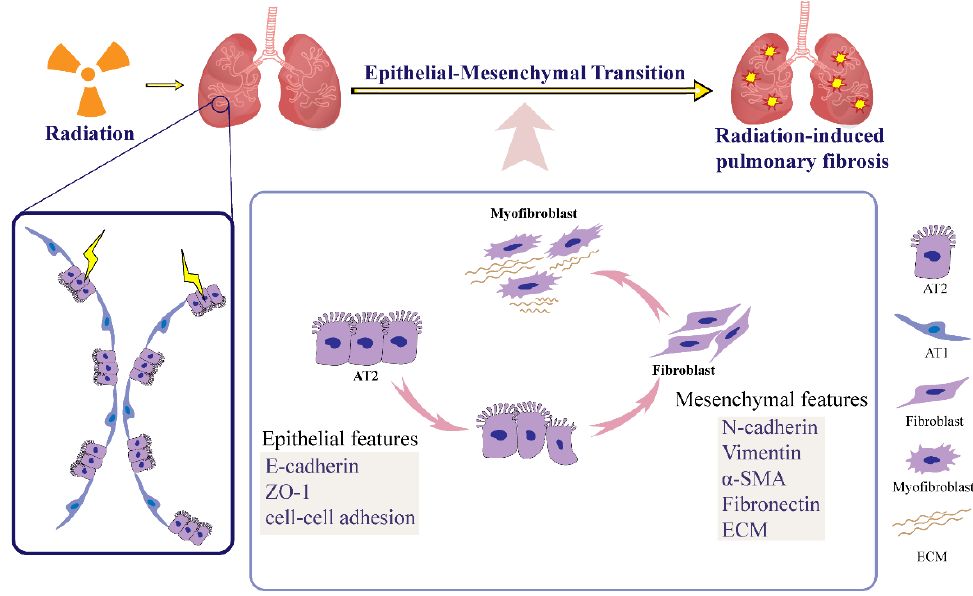
Figure 1. Radiation-induced EMT. Ionizing radiation induces epithelial–mesenchymal transition in AT2 cells, which lose their tight intercellular junctions and gradually lose their epithelial phenotype, eventually allowing them to acquire a mesenchymal phenotype and differentiate into fibroblasts. Thereafter, fibroblasts proliferate and activate in large numbers, further differentiating into myofi- broblasts, which secrete large amounts of extracellular matrix components, leading to excessive dep- osition of extracellular matrix and promoting the development of RIPF. (AT1-alveolar type I epithe- lial, AT2-alveolar type II epithelial, ECM-extracellular matrix, ZO-1-zonula